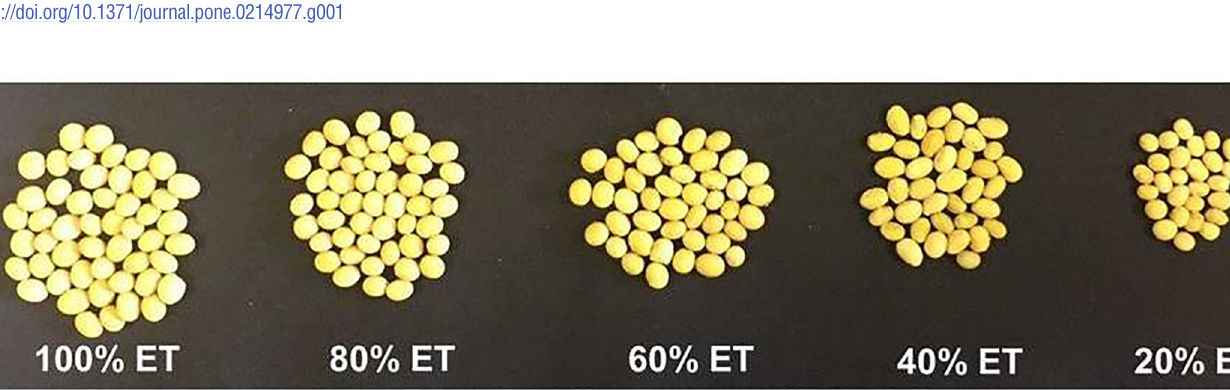
PLOS ONE | https://doi.org/10.1371/journal.pone.0214977 September 9,